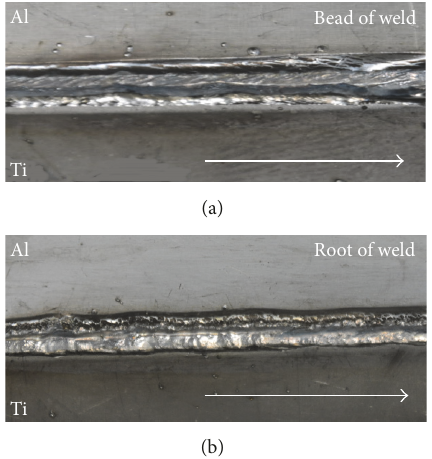
Figure 15: Appearance of the butt weld joint prepared with the laser power of 800 W and the laser offset of 250 𝜇 m: (a) bead of weld and (b) root of